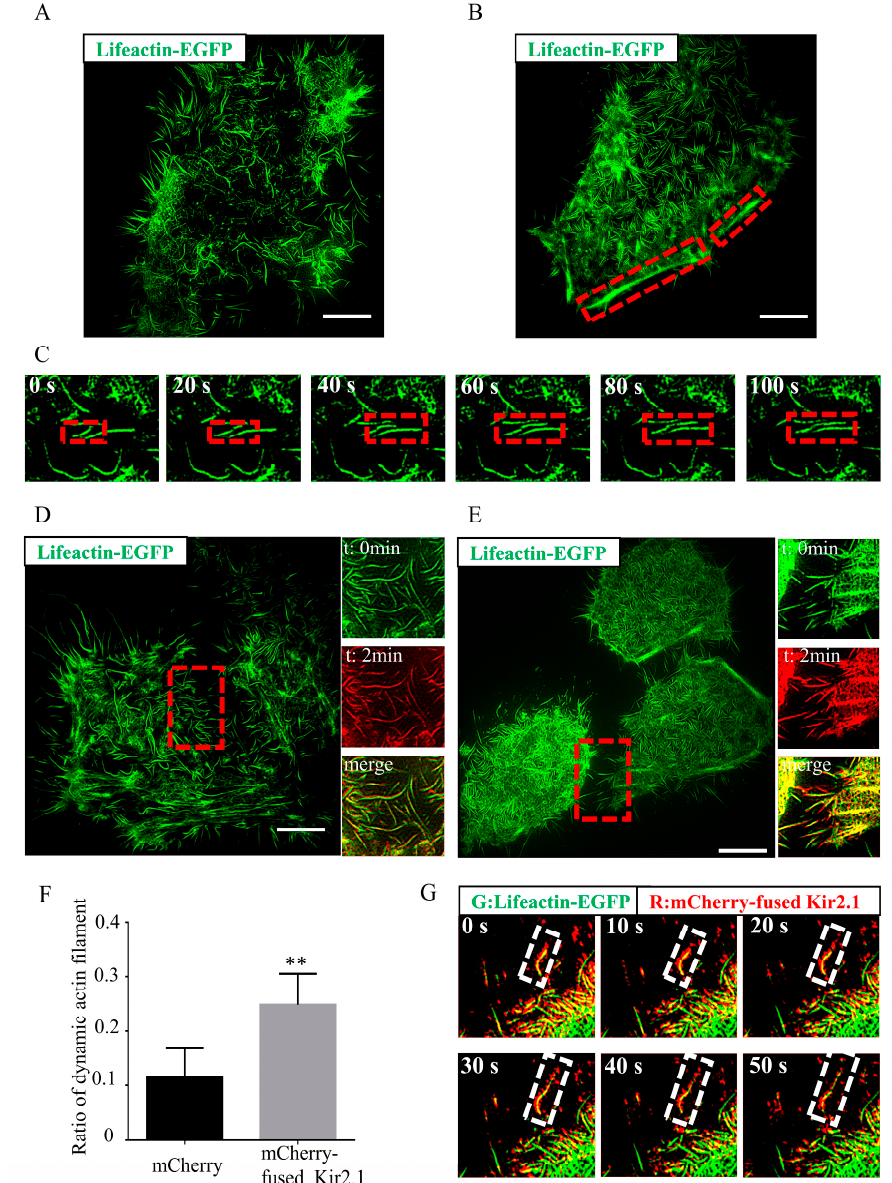
Figure 1. Kir2.1 regulates actin filament morphology and actin dynamics. ( A ) and ( B ) Actin filaments of Hela cells imaged by structured illumination microscopy (SIM). Hela cells were transfected with lifeact-EGFP and mCherry ( A ), lifeact-EGFP and mCherry-fused Kir2.1 ( B ), Scale bar: 5 µ m. The red dotted frames show that actin filaments assembled in clusters. ( C ) Actin filaments in wild-type Hela cell imaged by SIM. Hela cells were transfected with lifeact-EGFP. Images in the red dotted frame show detailed growth of one actin filament. Most of the actin filaments are stable. ( D ) and ( E ) The dynamics of actin filaments in Hela cells imaged by SIM. Hela cells were transfected with lifeact-EGFP and mCherry ( D ), lifeact-EGFP and mCherry-fused Kir2.1 ( E ). Magnified images show detailed actin filaments. Actin filaments at di ff erent time frames were labeled with di ff erent pseudo colors (T = 0 min, green; T = 2 min, red); colocalized actin filaments represented the stable actin filaments in the merged image, while the non-overlapping actin filaments were dynamic ones. Scale bar: 5 µ m. ( F ) Quantification of the dynamic actin filament ratio. The image of representative cells is shown in (D) and (E); n = 5 cells. Values are mean ± SEM. ** p < 0.01. ( G ) Movement of mCherry-fused Kir2.1 monitored by SIM. Hela cells were transfected with lifeact-EGFP and mCherry-fused Kir2.1. Magnified images show in the white dotted